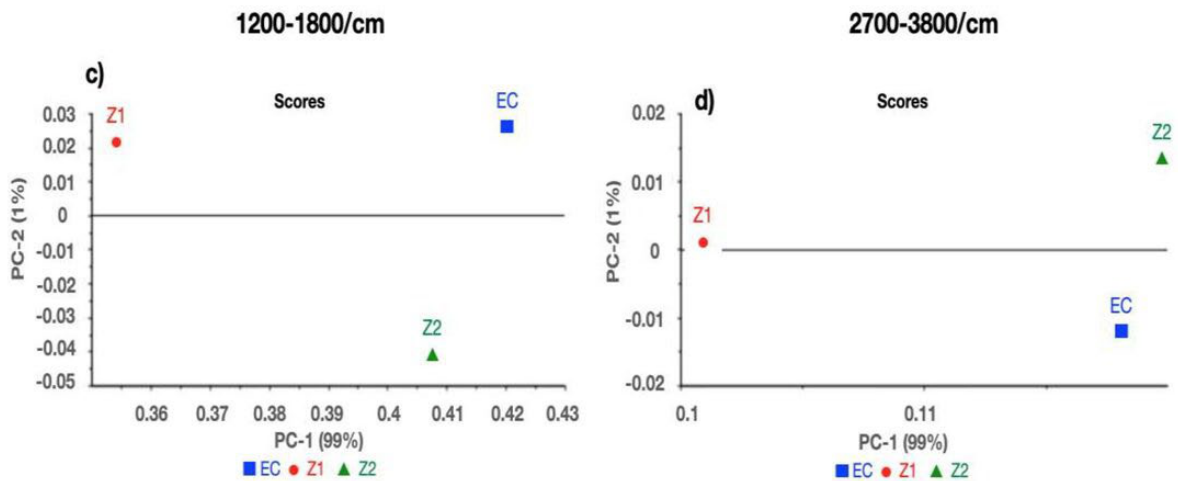
Figure 2. Principal component analysis (PCA) of EQUIA coat (E), 1% ZnO (EZ1), and 2% ZnO (EZ2) at spectral ranges ( a ) 600–800/cm, ( b ) 800–1200/cm, ( c ) 1200–1800/cm, and ( d ) 2700–3800/cm. Sample groupings and inner group variations were observed using cluster analysis (Figure 3a,b), which complemented the findings of the principal component analysis. Maximum differences were observed in E and EZ1 at the complete spectral range (Figure 3b). However, exceptional separation was overall recorded between the comparisons (a),(b). The FTIR spectra analyses of the peak height of the control and experimental samples are shown in Figure 4. It was found that the intensities of peak groups (C–H, C=O, C=C, N–H, and C–O–C) were reduced after incorporating ZnO and TiO 2 in EC.